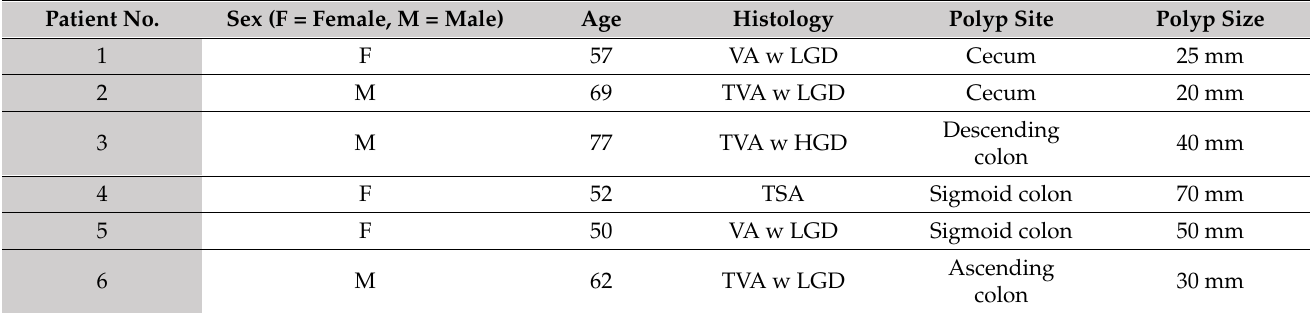
Table 1. Patient and polyp